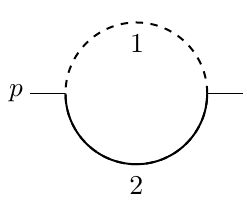
Figure 7 . Single mass bubble